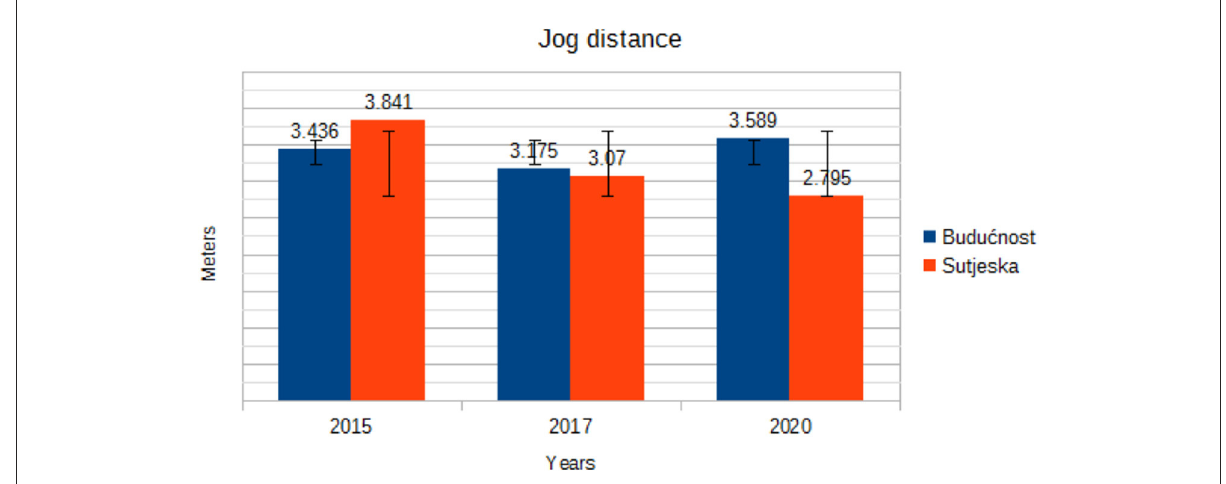
FIGURE3 Trend in mean jog distance by years.